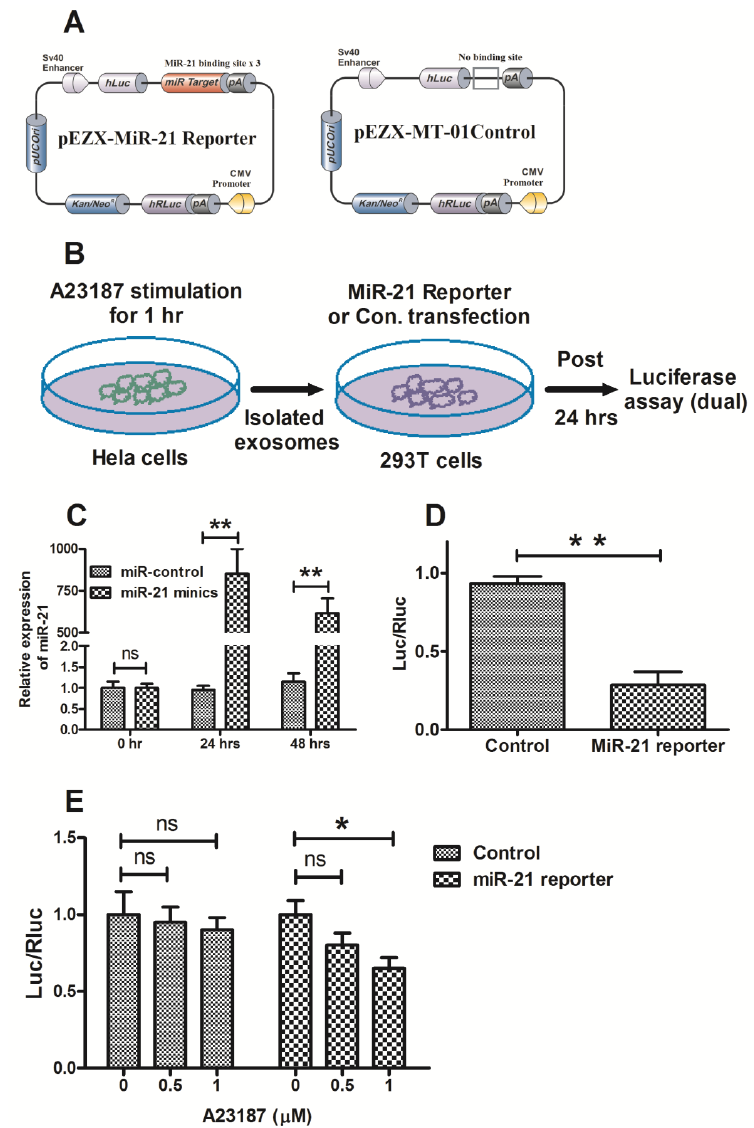
Figure 6. Exosomal microRNA-21 was functional in recipient cells. ( A ) Schematic diagram of pEZX-MT01 plasmid containing luciferase reporters with or without the target sequence of microRNA-21; ( B ) Schematic for detecting the function of microRNA-21 in the released exosomes; ( C ) The expression of microRNA-21 was significantly up-regulated in 293T cells after transfection with the microRNA-21 mimics; ( D ) Relative luciferase activity of miR-21 sensor reporter or sensor control in 293T cells transfected with the microRNA-21 mimics; ( E ) Exosomal microRNA-21 from Hela cells significantly reduced the luciferase activity of the sensor reporter in 293T cells. All the exosome samples released from cells were quantified by the ELISA for CD9 before miRNA assay. In addition, all experiments were performed in triplicate. Statistical significance was considered with p < 0.05 ( * ) and p < 0.01 ( ** ). ns, no